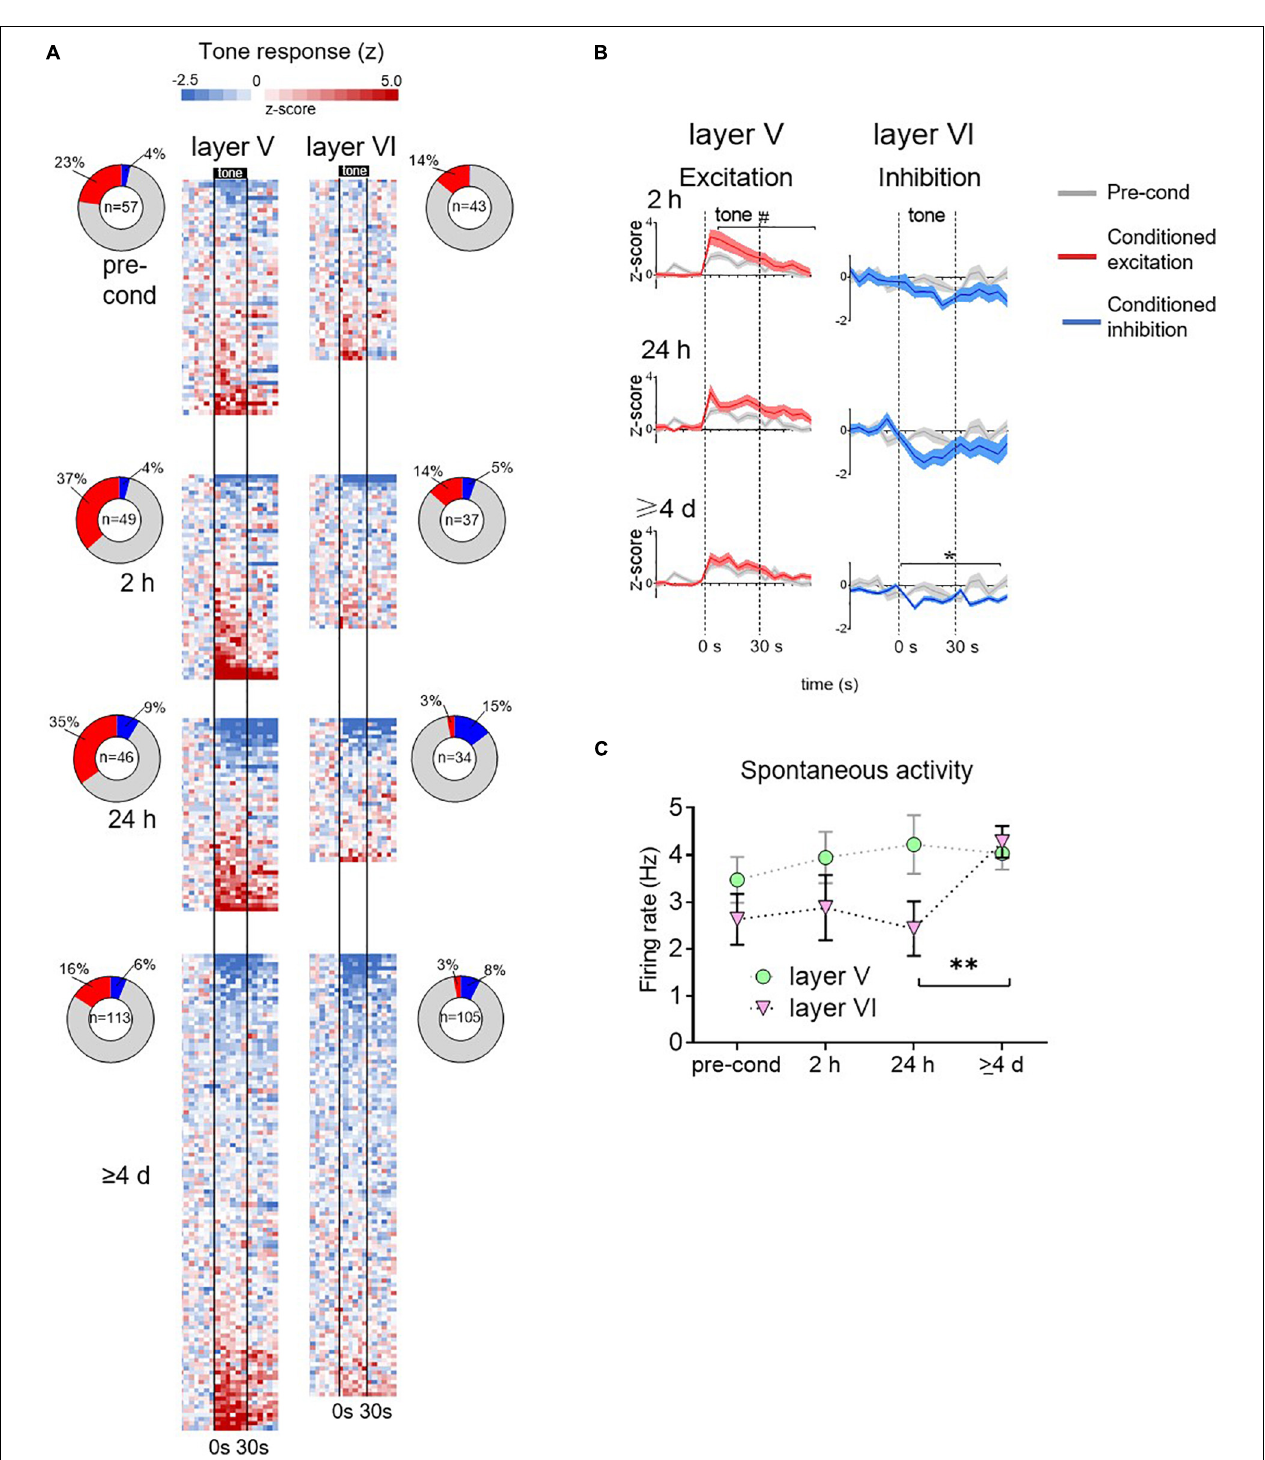
FIGURE 3 | Group data for time-dependent changes in conditioned responses of PL neurons. (A) Tone responses of all neurons recorded at each timepoint, based on color-coded depiction of z-scores normalized to pre-tone rate. Each row is a separate cell, and bins are 5 s. Cells are ordered based on the magnitude of the z score averaged across the tone. Vertical black lines indicate onset and offset of 30 s tone. Inset: ring depicts the percentage of neurons showing significant excitatory or inhibitory responses at each timepoint. Number in center indicates the number of cells recorded at that timepoint. (B) Averaged tone responsiveness of layer V and layer VI neurons, showing trends toward conditioned excitation ( z > 0, red) or toward conditioned inhibition ( z < 0, blue). (C) Group data of spontaneous firing rate of PL neurons in layer V and VI (calculated from 60 s period prior to onset of first tone). The spontaneous rate of layer VI neurons significantly increased at the ≥ 4 days timepoint. # p = 0.11; ∗ p < 0.05; ∗∗ p <